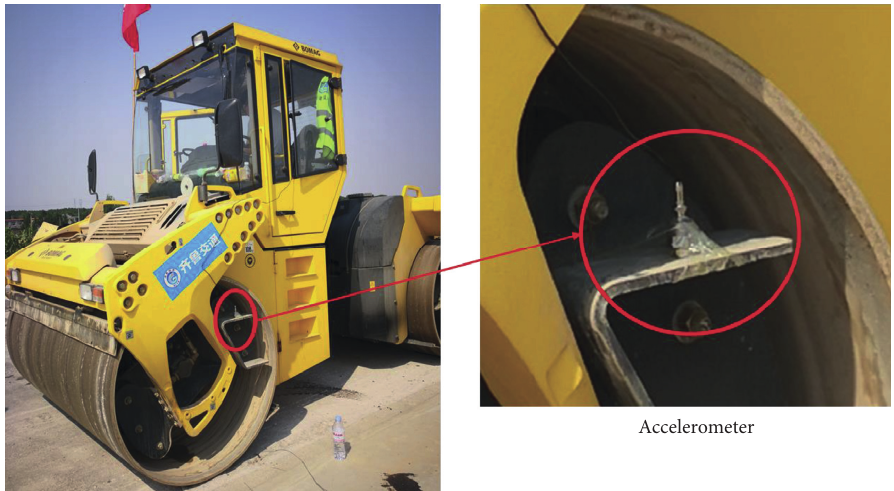
Figure 1: Accelerometer-equipped vibratory roller during compaction.